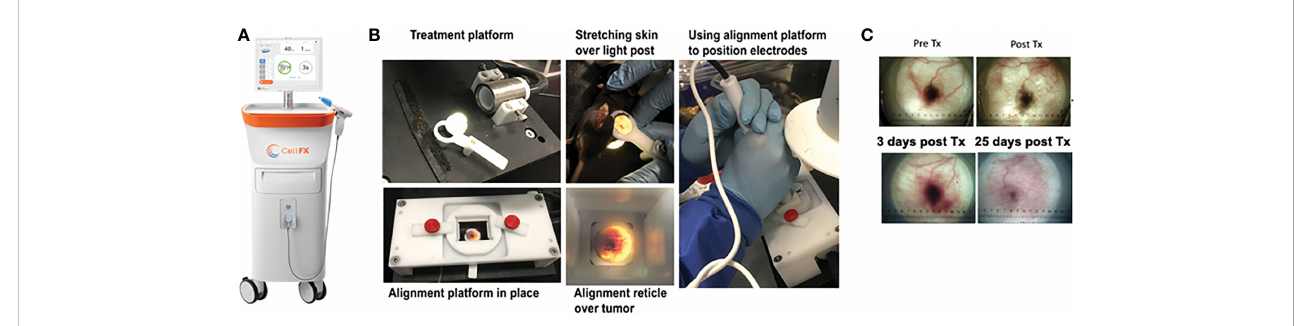
FIGURE 1 Images of the CellFX ™ treatment platform and a treated melanoma tumor. (A) CellFX Pulse Generator; (B) Montage of images illustrating the procedure used to treat the melanoma tumors by stretching the skin containing the tumor over a translucent silicone light post and aligning the tumor with the application electrode followed by treatment with the CellFX system; (C) Transillumination images of a typical melanoma over time, Before treatment, immediately after treatment, 3 days post treatment and 25 days after